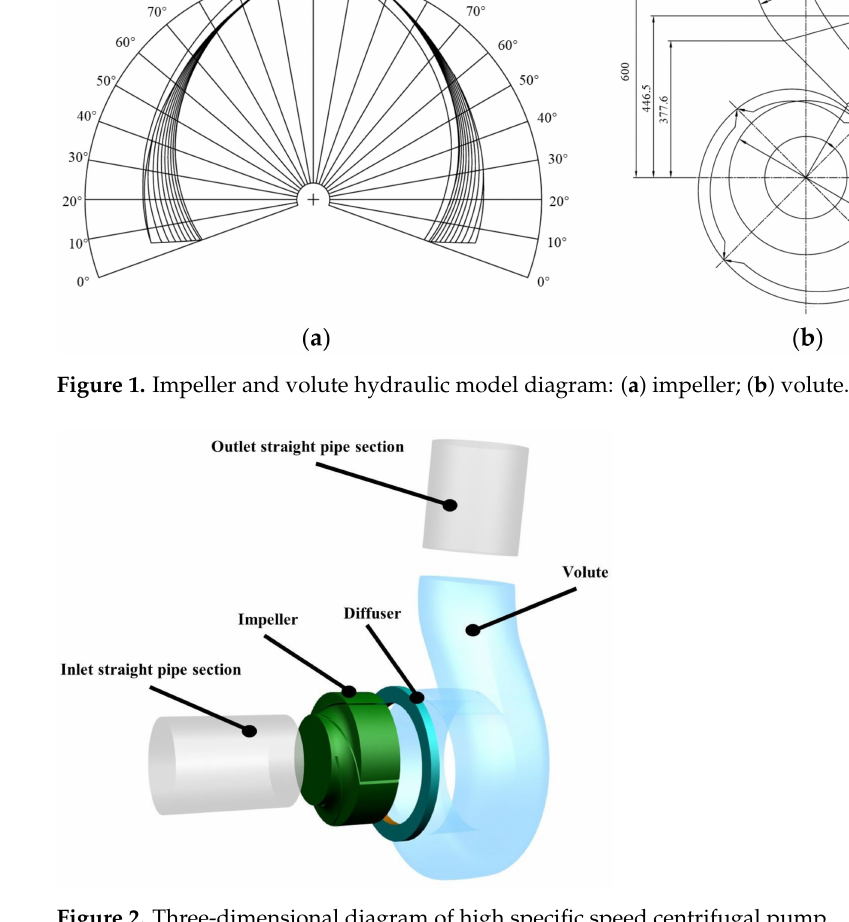
Figure 2. Three-dimensional diagram of high specific speed centrifugal pump.